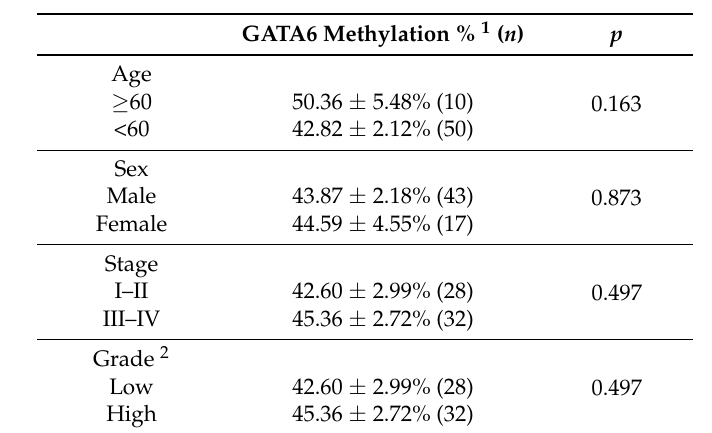
Figure 5. Immunohistochemistry examination of GATA6, TFF1 and TFF2 in gastric cancer patient samples: Samples with low GATA6 methylation ( left panel) have higher expression of GATA6 ( A ) as well as TFF1 ( B ) and TFF2 ( C ) as indicated by brown color (arrow). In contrast, samples with high GATA6 methylation ( right panel) have lower expression of GATA6 ( D ), TFF1 ( E ), and TFF2 ( F ). Magnification, 100×. Table 1. Relationship between clinical parameters and GATA6 methylation among the 60 patients with gastric cancer.